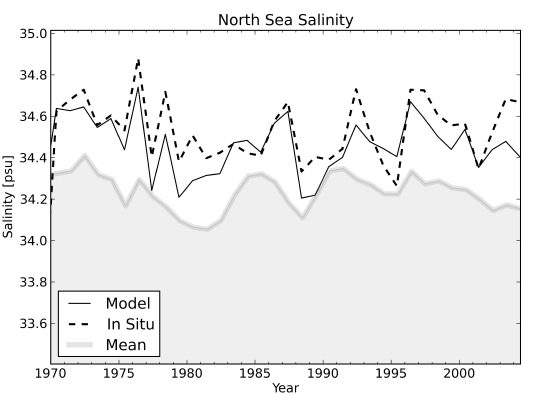
Fig. 13. Annual North Sea salinity time series: the black line is the matched model mean annual salinity, the dashed line the mean annual in situ salinity, and the grey area shows the MLD-averaged mean salinity of the North Sea.